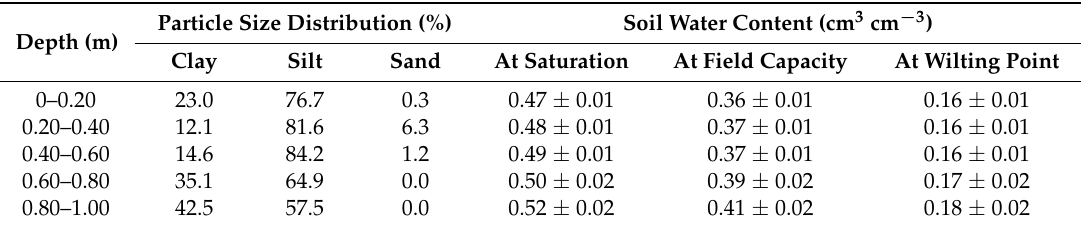
Table 1. Main soil textural and hydraulic properties of the soil in Dengkou (from [14]).